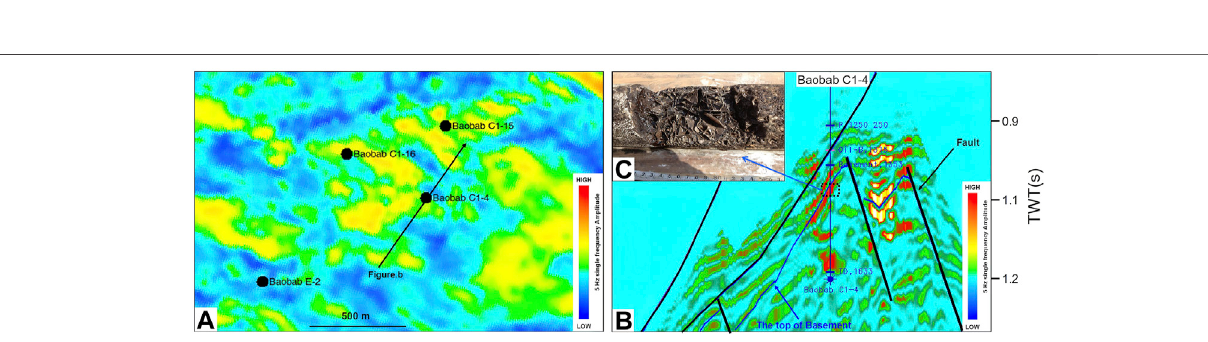
Frontiers in Earth Science |